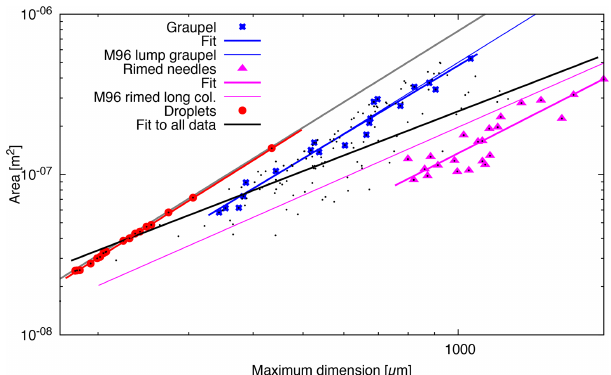
Figure 11. Fall speed versus maximum dimension D for snowfall measured on 19 October 2014 between approximately 06:00 and 19:00UTC. Fits to all data (black dots) and to three subsets corre- sponding to graupel, rimed needles, and droplets are shown as lines in the same colour as the corresponding data points. In addition, two relationships predicted from area and mass relationships using the method reported by Mitchell (1996, Eqs. 12 and 20, referred to as M96 in the legend) are shown as thinner lines: one for rimed long columns (magenta) and one for lump graupel